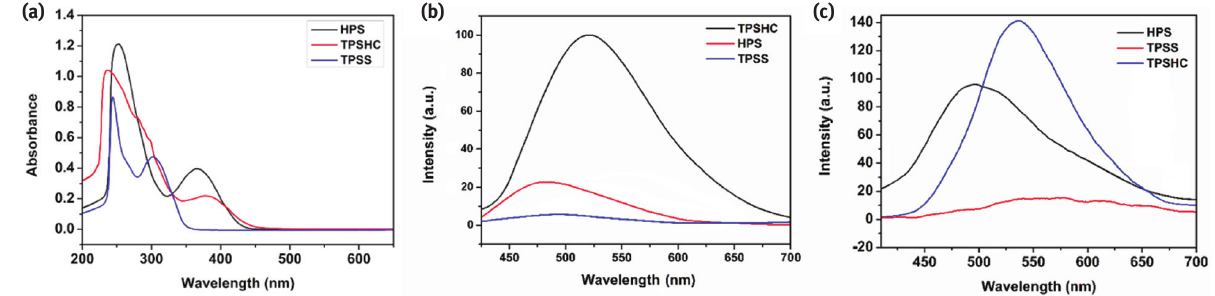
Figure 2: UV-Vis spectra (a) and luminescent spectra of TPSHC, HPS, and TPPS in the solution (b) and solid state